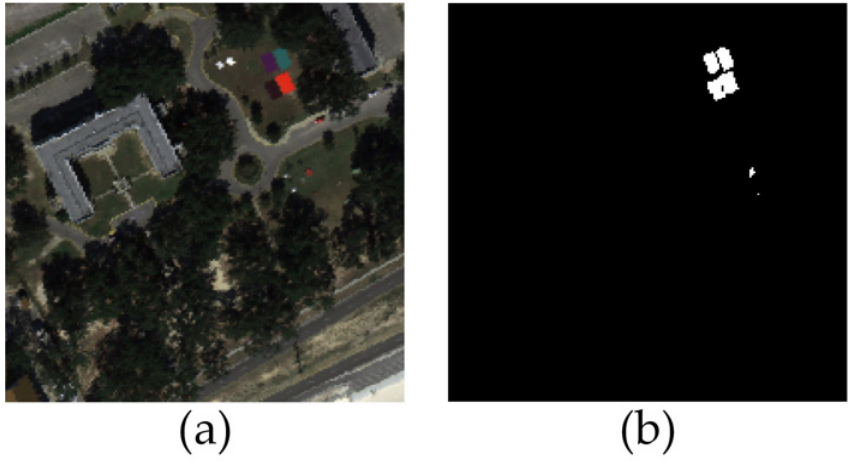
Figure 5. MUUFL Gulfport dataset: ( a ) false–color map of the MUUFL Gulfport dataset; ( b ) ground truth map.